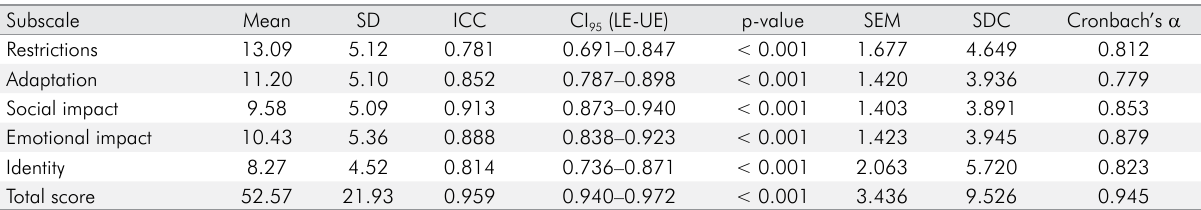
Table 2. Mean score, test retest reliability, and internal consistency for the subscales and the total sum of the Brazilian DHEQ-15. Subscale